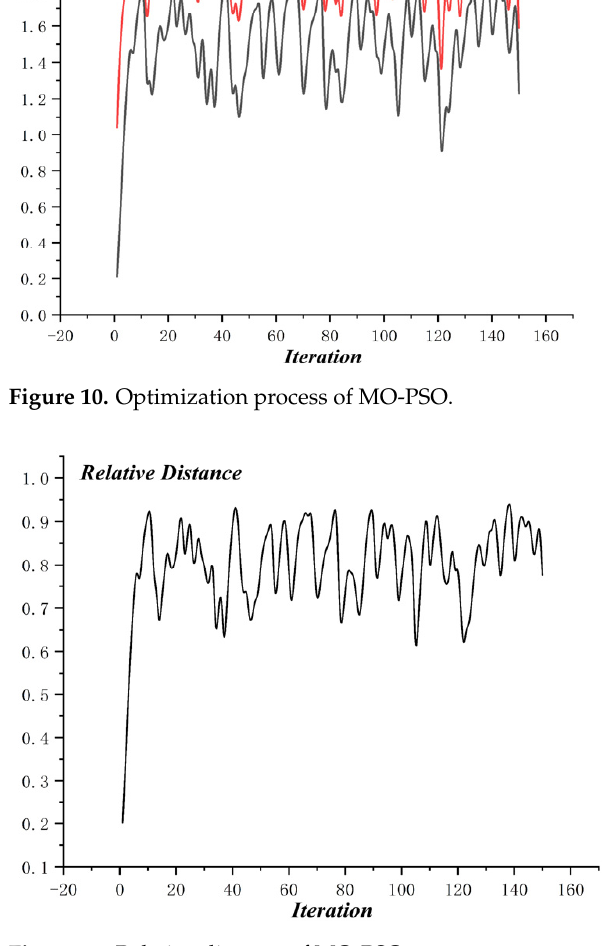
Figure 11. Relative distance of MO-PSO.